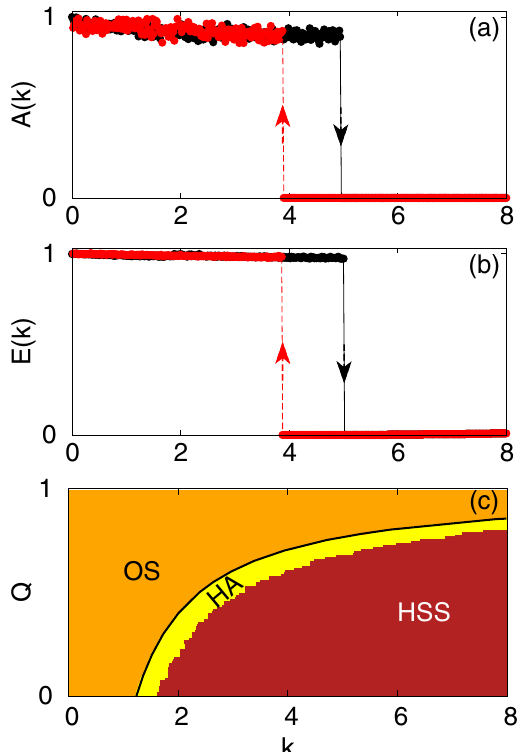
Figure 3. Forward (black) and backward (red) continuation diagram of ( a ) the normalized amplitude, A ( k ), and ( b ) normalized mean incoherent energy, E ( k ), under the variation of the coupling strength, k , for Q = 0.7 and ( c ) different dynamical regions in the parameter space of ( k − Q ), of N = 100 coupled Lorenz oscillators. For details see the